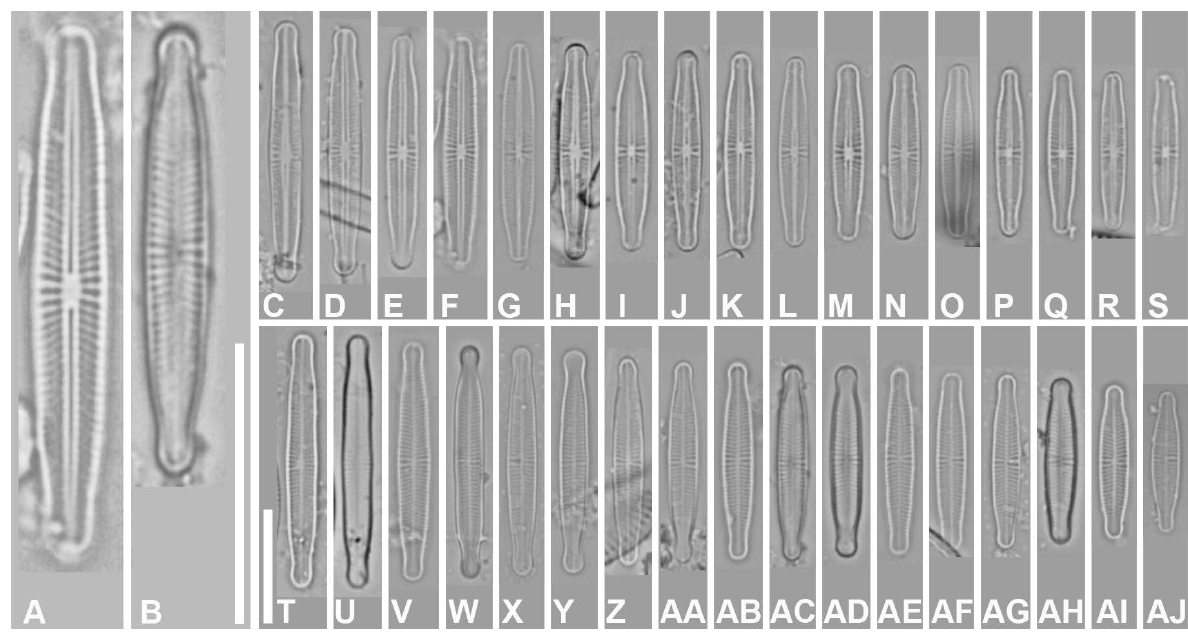
Figure 2. Achnanthidium barlasii sp. nov., LM micrographs. A , C – S . LM views of raphe valves. B , T – AJ . LM views of rapheless valves. Scale bar = 10 µm (A, B: 2500×; C–AJ: 1000×